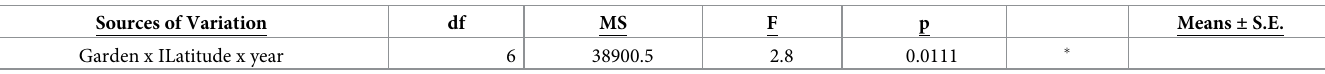
and reaction ST